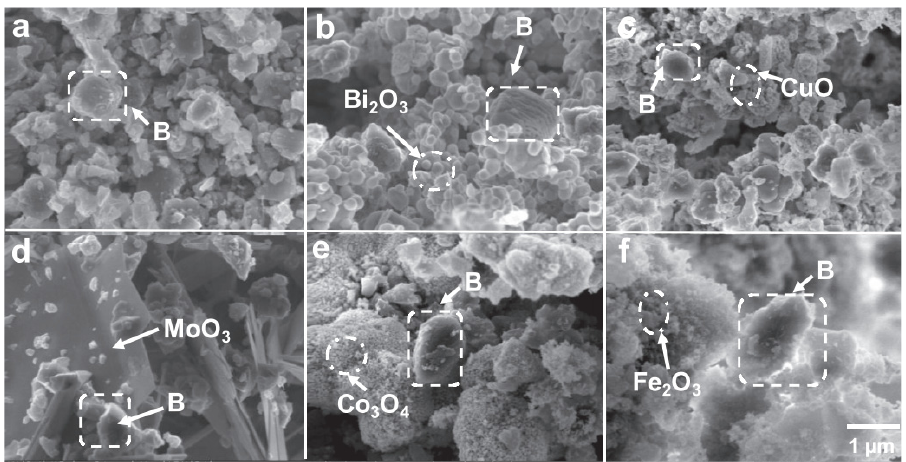
Figure 4. SEM of ( a ) boron particles, ( b ) stoichiometric B–Bi2O3, ( c ) B–CuO, ( d ) B–MoO 3 , ( e ) B–Co 3 O 4 , and ( f ) B–Fe 2 O 3 [31]. and ( f ) B–Fe 2 O 3 . Reprinted with permission from Ref. [31]. Copyright 2019